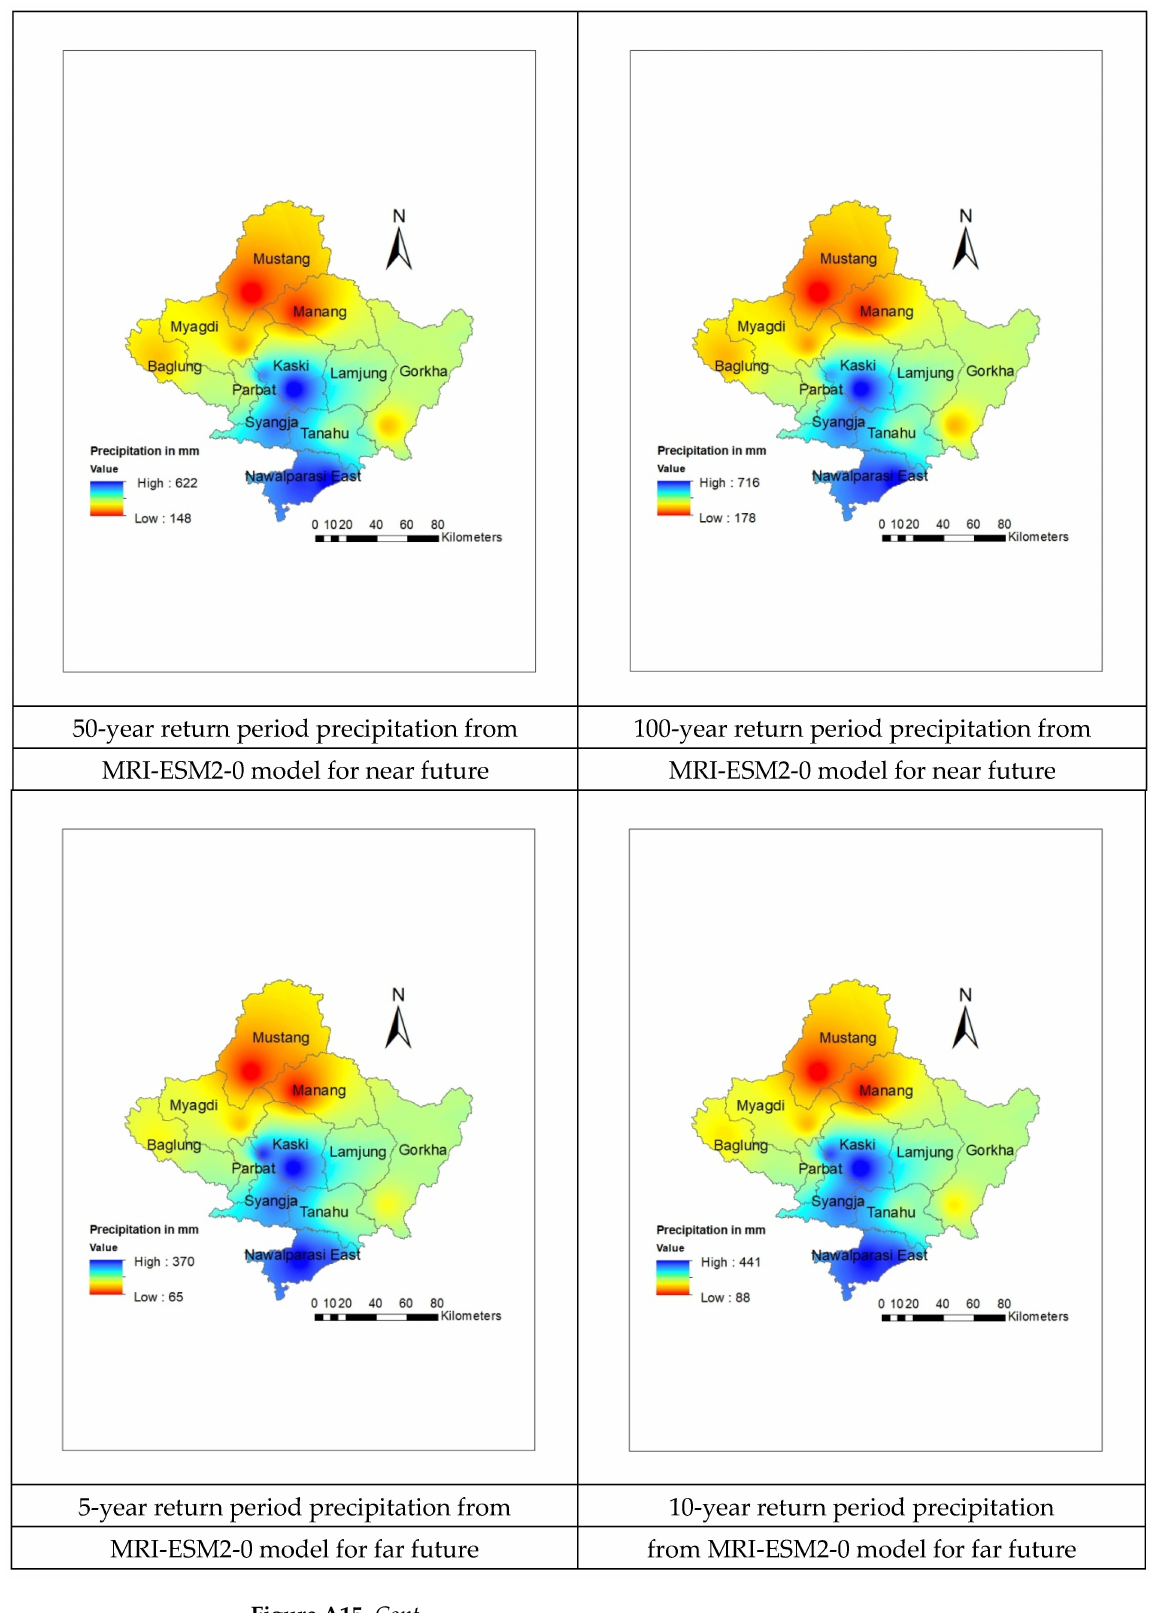
Figure A15. Cont